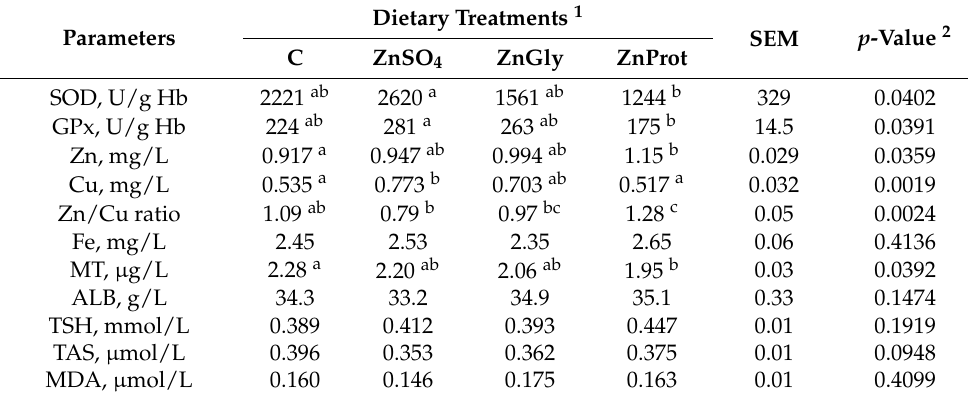
Table 3. Activity of antioxidant enzymes (i.e., SOD and GPx) in blood, plasma mineral concentration, and other plasma parameters of lambs fed diets (80 mg Zn/kg) differing in Zn source after the 120 day feeding period.